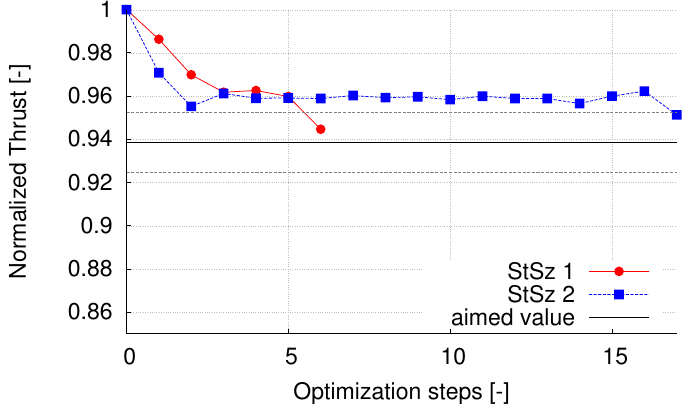
Figure 6. Development of the normalised thrust force over the optimization steps for the long blade part. The aimed force is 900 ± 1.5% N and the initial step sizes are 10 − 2 (red dots, StSz1) and 2 × 10 − 2 (blue squares,